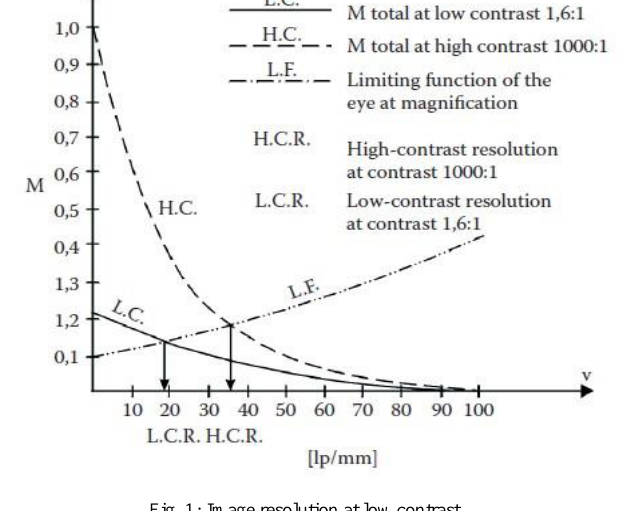
Fig. 1: Image resolution at low contrast